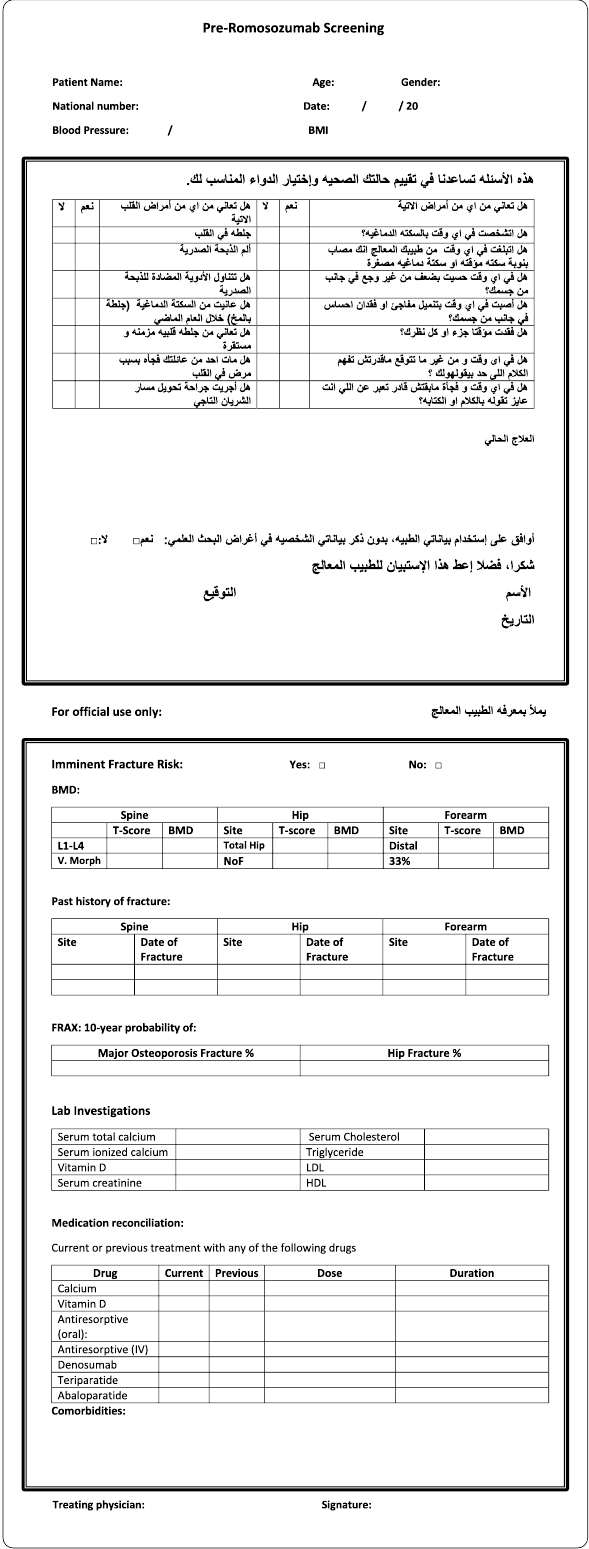
Fig. 1 Pre-romosozumab, patient self-reported questionnaire to screen for possible risks. It also include the baseline bone health status as assessed by the treating healthcare